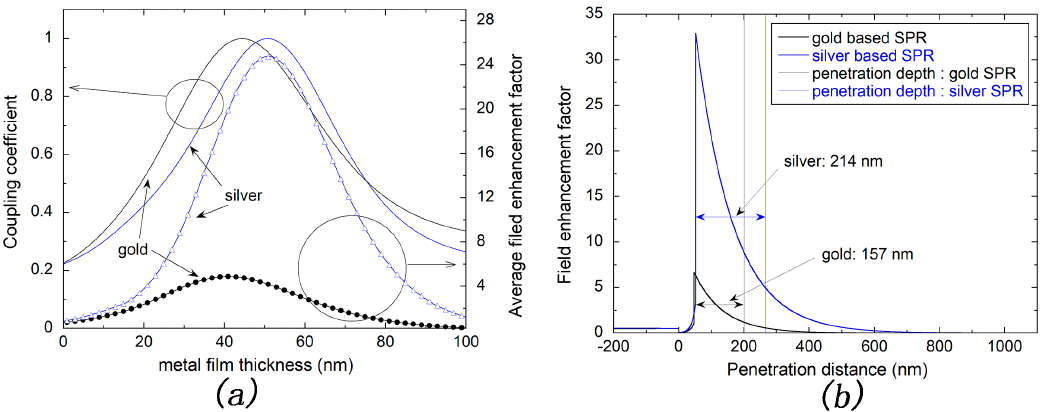
Figure 2. ( a ) Coupling coefficient and average field enhancement factor of gold or silver-based surface plasmon resonance (SPR) sensor with the change of metal film thickness; ( b ) Field enhancement factor versus the penetration distance for silver (50 nm), gold (45 nm).